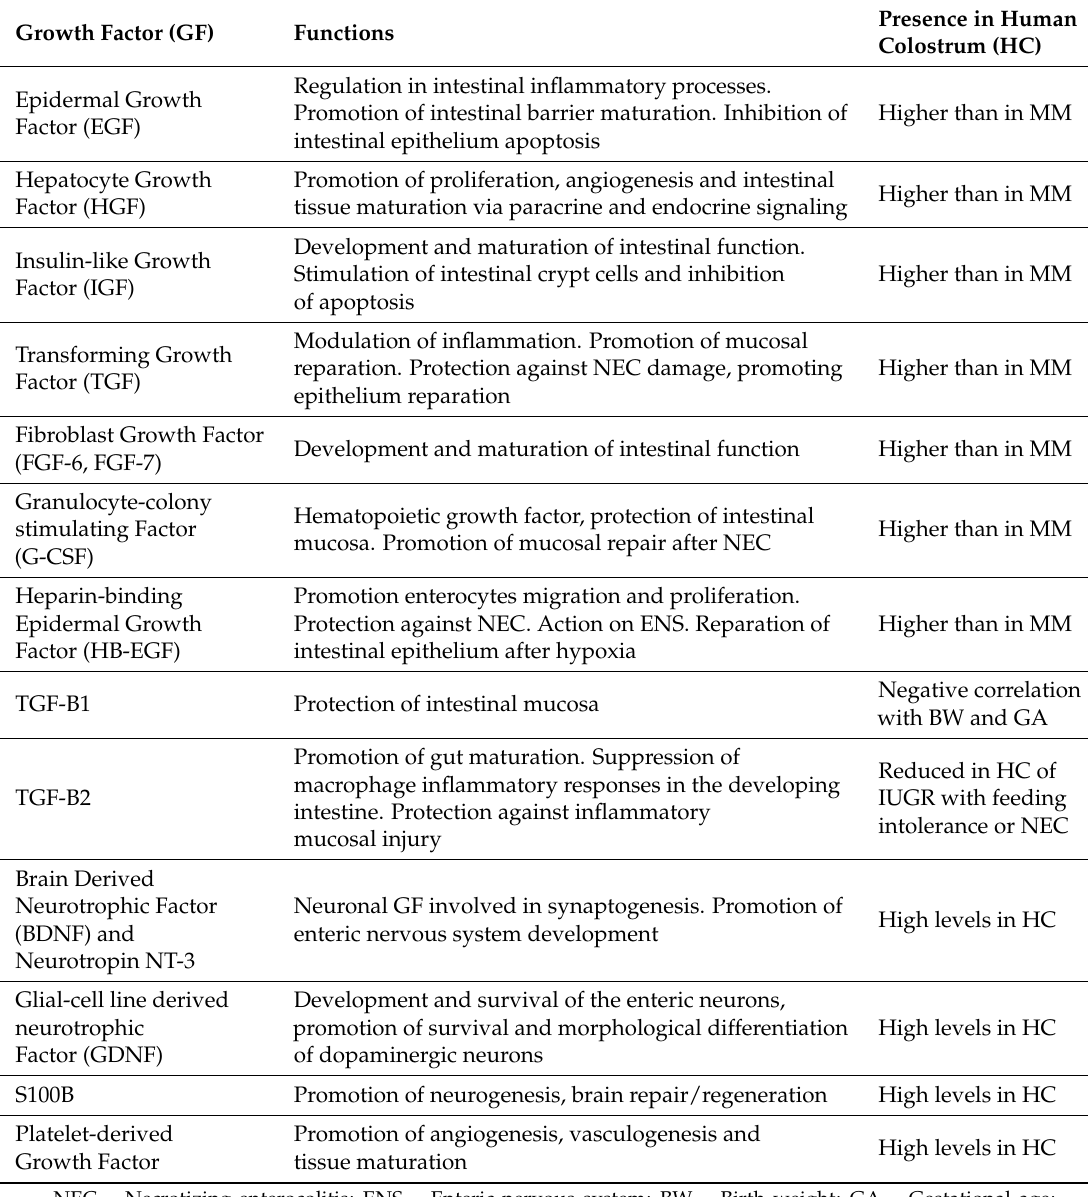
Table 1. Table resuming growth factors (GF) detected in human colostrum (HC), their functions and their levels in colostrum instead of mature milk